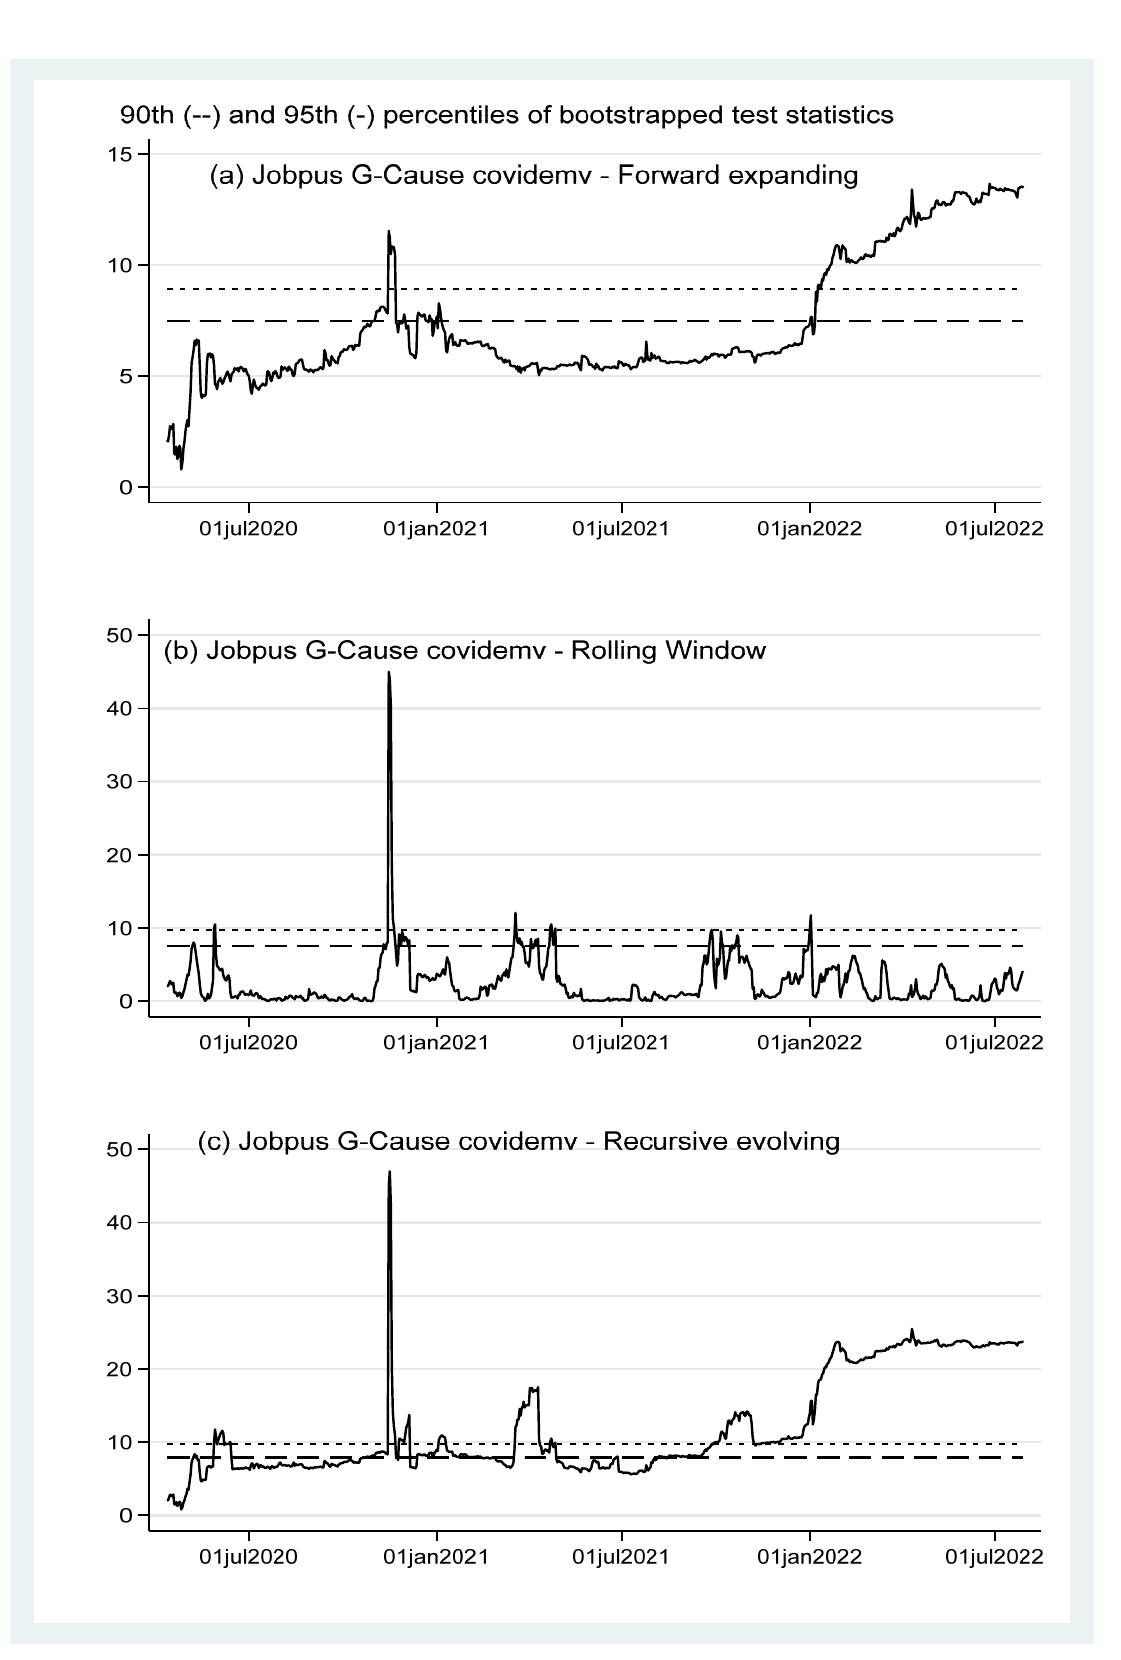
Figure 5. Date stamping the causality behavior running from manufacturing job postings to COVIDEMV between 1 January 2020 and 29 July 2022.